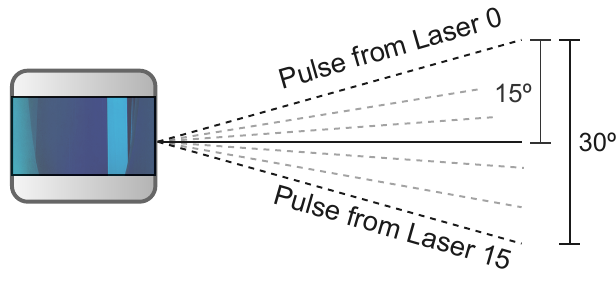
Figure 11. Velodyne VLP-16 side